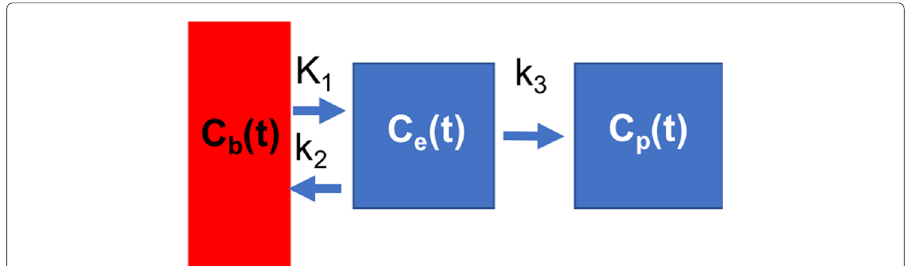
Fig. 1 Irreversible two compartmental model describing the kinetics of 18 F-FDG used to evaluate lung inflammation. In the absence of significant oedema, the concentration of 18 F-FDG in a ROI in the lung can be described by three compartments [9]: a blood compartment C b ( t ) , an extravascular pre-cursor pool C e ( t ) and phosphorylated (’trapped’) 18 F-FDG compartment C p ( t ) . The relationships between the concentration of tracer in a compartment is described by the rate constants (i.e. K 1 , k 2 , k 3 ). ROI =